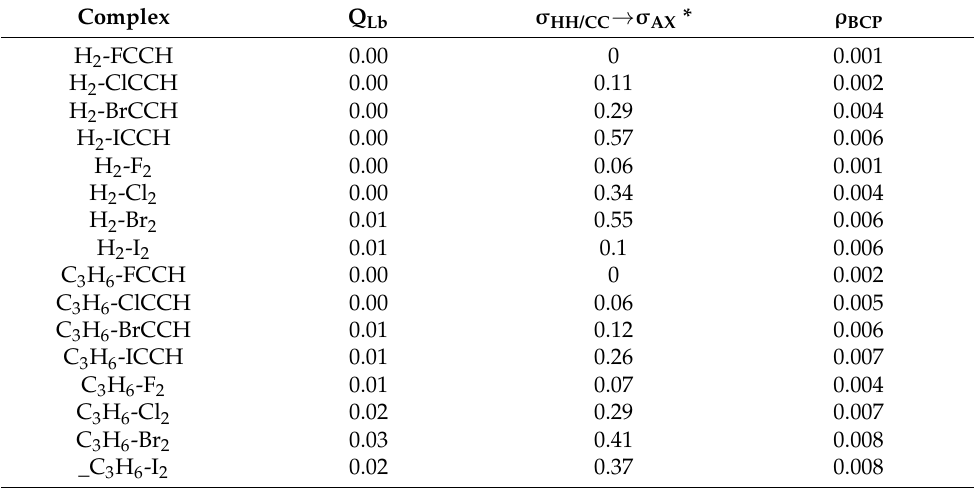
Table 3. The characteristics related to the electron charge transfer: the NBO charge of the Lewis base unit (au), Q Lb , the energy of σ HH/CC → σ AX *, orbital–orbital interaction (kcal/mol), and the electron density at X · · · σ (or X · · · H/C) BCP (in au), ρ BCP . Complex Q Lb σ HH/CC → σ AX * ρ BCP H 2 -FCCH 0.00 0